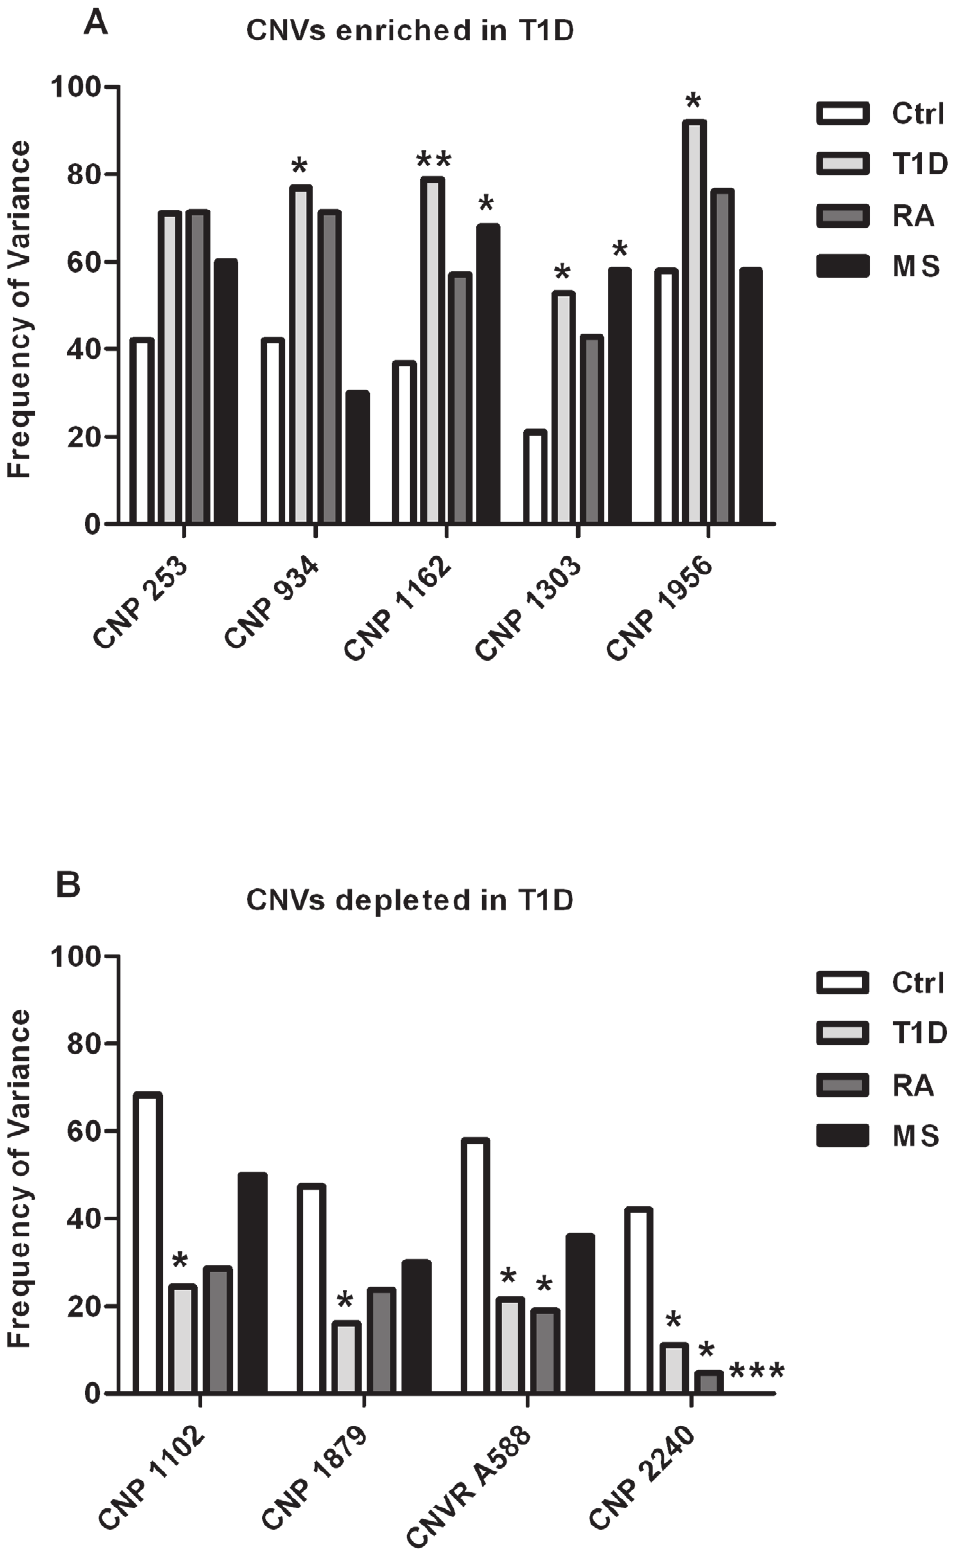
Figure 3. Frequencies of CNVs in other autoimmune diseases. Panel A. Frequency of CNPs identified as enriched in the T1D cohort in the Ctrl, pooled T1D, RA and MS cohorts. Panel B. Frequency of CNVs identified as depleted in the T1D cohorts, in Ctrl, pooled T1D, RA and MS cohorts. Ctrl n=19, T1D n=38, RA n=21, MS n=50. p -values determined by chi-square analysis, *= p , 0.05, **= p , 0.005 and ***= p , 0.0005.